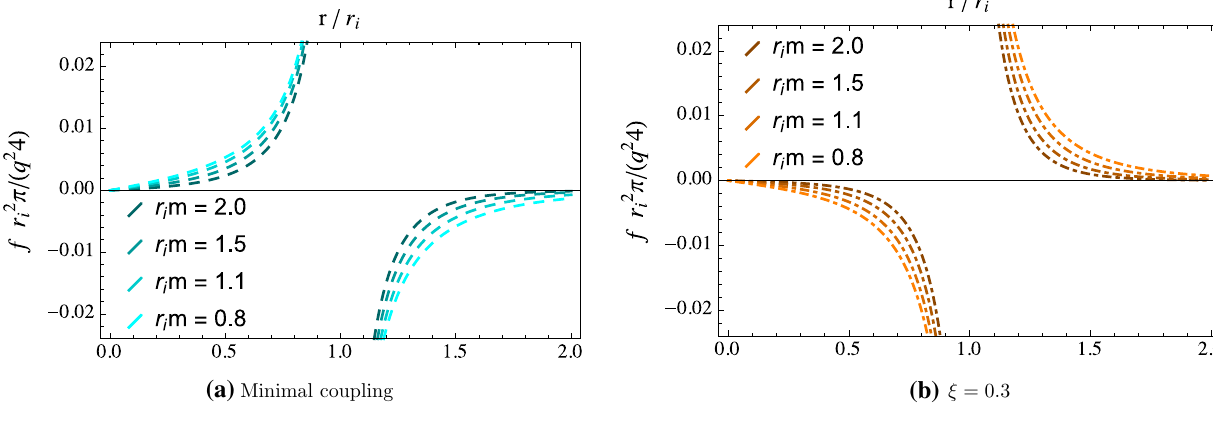
Fig. 3 Dimensionless self-force